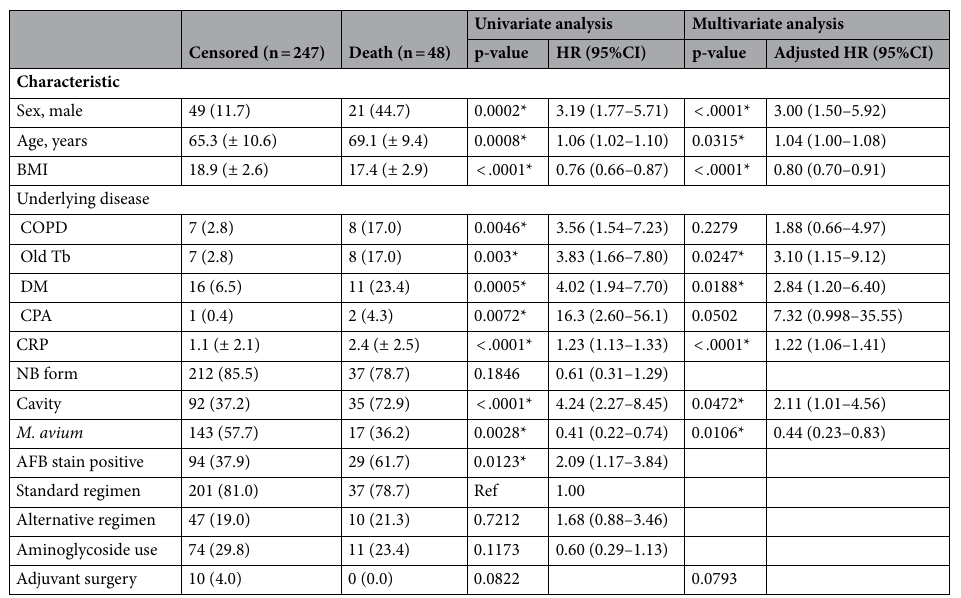
Table 4. Risk factors for MAC-PD mortality. Data represent n (%) or median (interquartile range). MAC-PD Mycobacterium avium complex pulmonary disease; HR hazard ratio; CI confidence interval; BMI body mass index; COPD chronic obstructive pulmonary disease; Tb tuberculosis; DM, diabetes mellitus; CRP C-reactive protein; NB nodular bronchiectasis; CPA chronic pulmonary